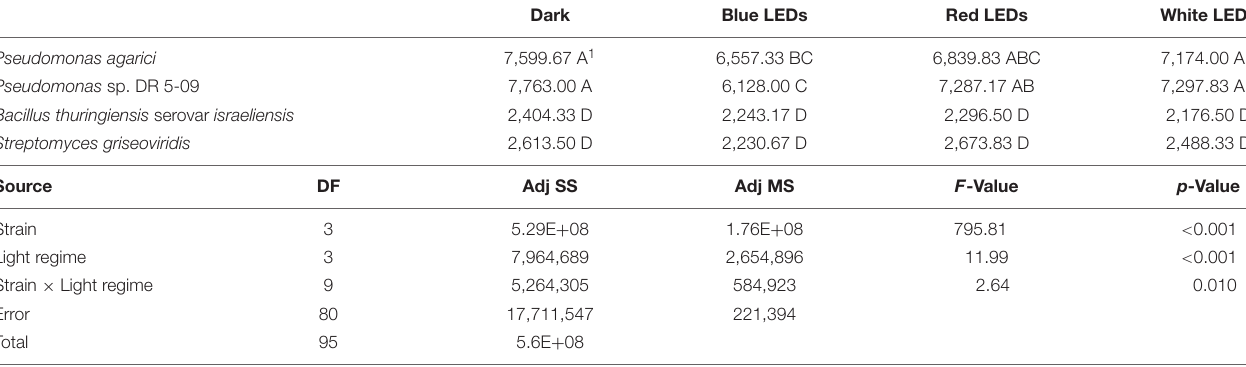
TABLE 1 | Substrate utilization of selected sources (“co-catabolic substrate subset”) by two Gram-negative ( Pseudomonas agarici ; Pseudomonas sp. DR 5-09) and two Gram-positive ( Bacillus thuringiensis serovar israeliensis ; Streptomyces griseoviridis ) bacterial strains exposed to four light regimes during incubation (dark incubation, incubation under short-wave monochromatic blue, long-wave monochromatic red and continuous polychromatic white light-emitting diodes (LEDs) at 20 ◦